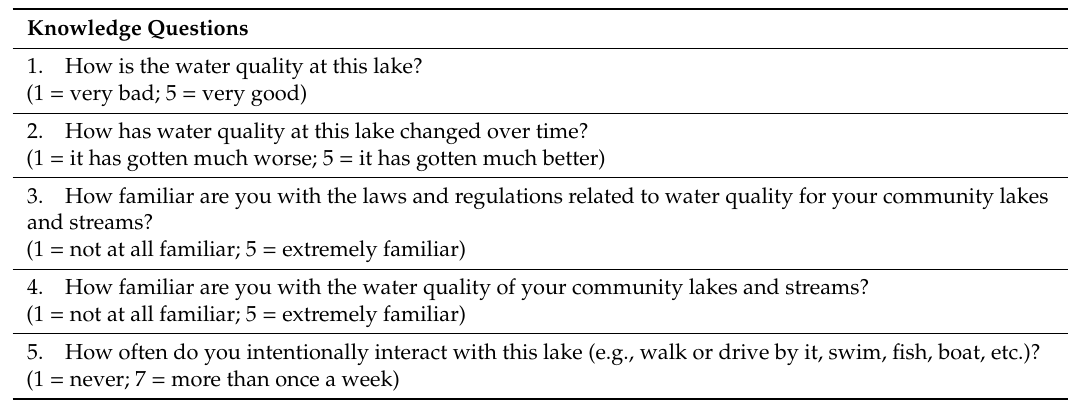
Table 3. Knowledge regarding water quality survey